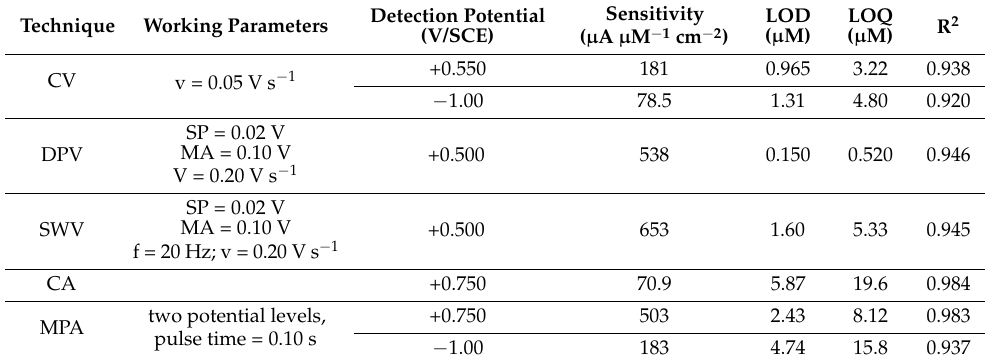
Figure 9. ( a ) Square-wave voltammograms recorded on CuBi/CNF electrode in 0.1 M Na 2 SO 4 supporting electrolyte, in the presence of various AMX concentrations: 0.2 mM, 0.4 mM, 0.6 mM, 0.8 mM, 1.0 mM, 1.2 mM, and 1.4 mM. Step potential (SP) of 0.02 V, modulation amplitude (MA) of 0.1 V. f = 20 Hz. ( b ) Calibration plots for AMX detection in the concentration range 0.2–1.4 mM recorded at the potential value of E = +0.500 V/SCE. Table 2. The electroanalytical parameters for AMX electrochemical detection using the CuBi/ CNF